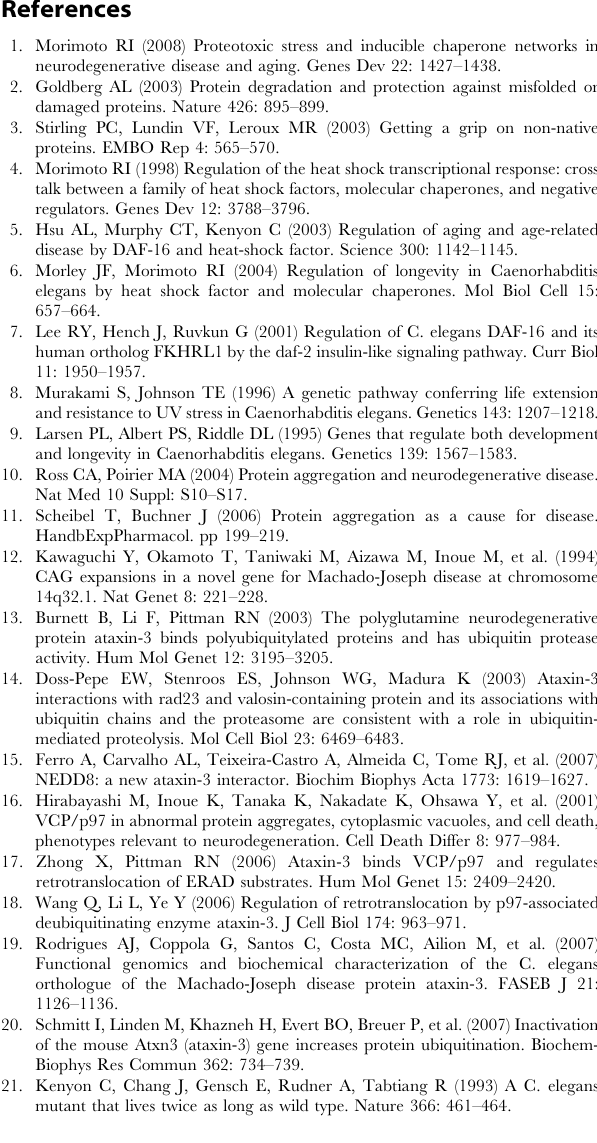
Table S2 Proteomic results from LC-ESI-MS/MS anal- ysis of two ataxin-3 knockout strains in a basal condition and after heat shock.